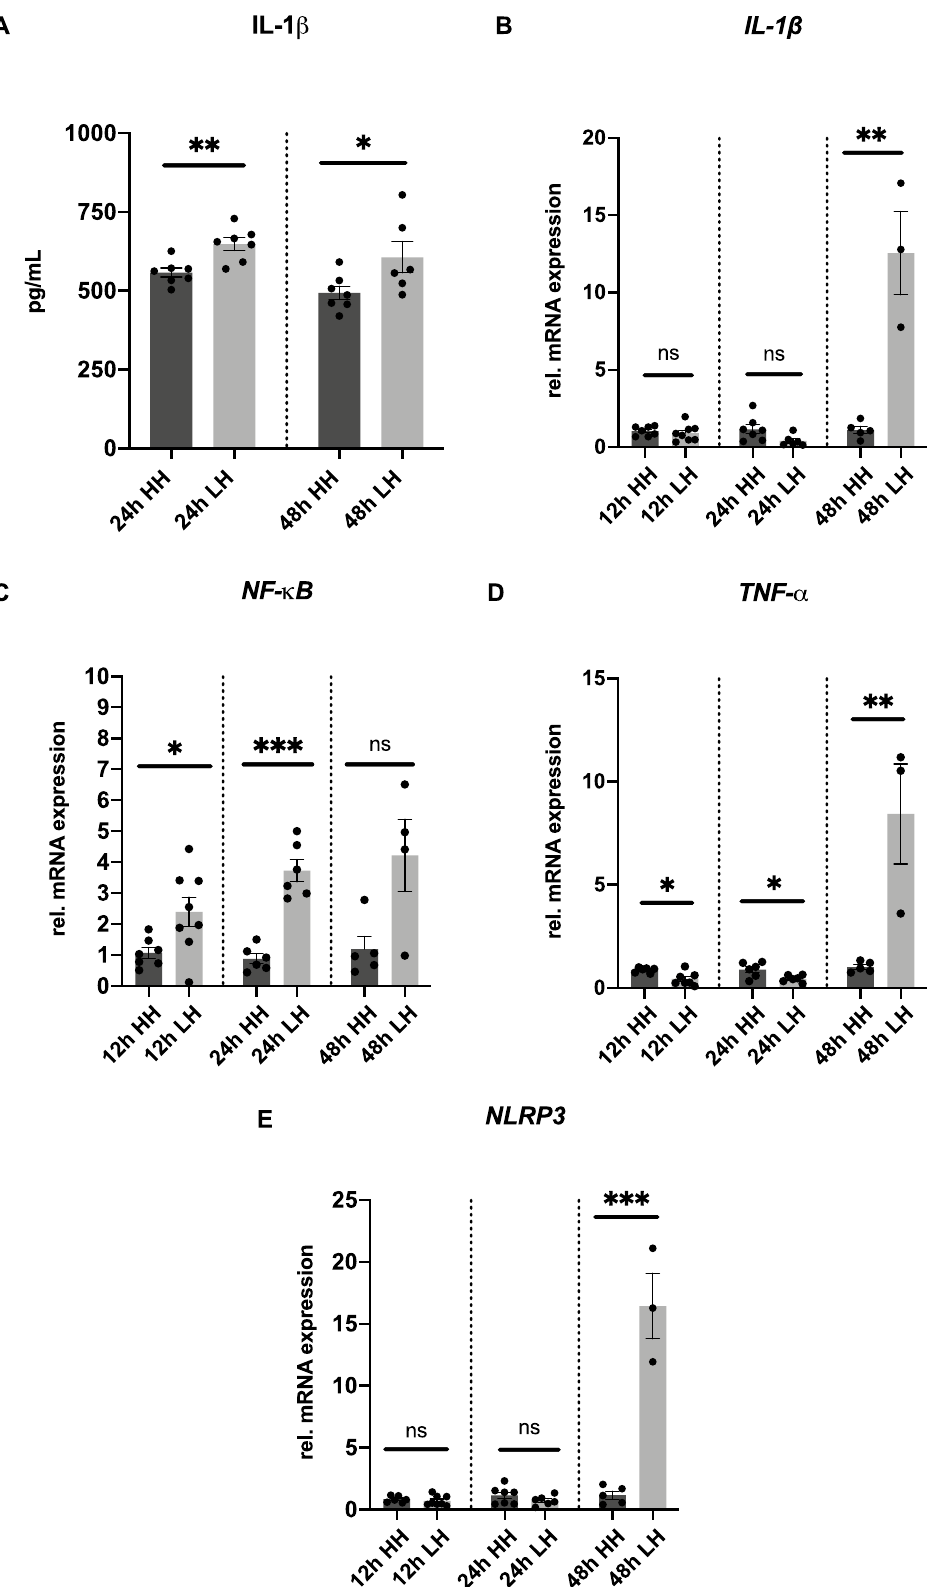
Figure 2. LH induces expression of inflammatory markers after LH treatment compared to incubation with HH. ( A ) A significantly higher secretion of IL-1 β was observed in porcine corneas submitted to LH for 24 h (648.30 pg/mL ± 20.30) when compared to 24 h HH (558.20 pg/mL ± 14.50; p =